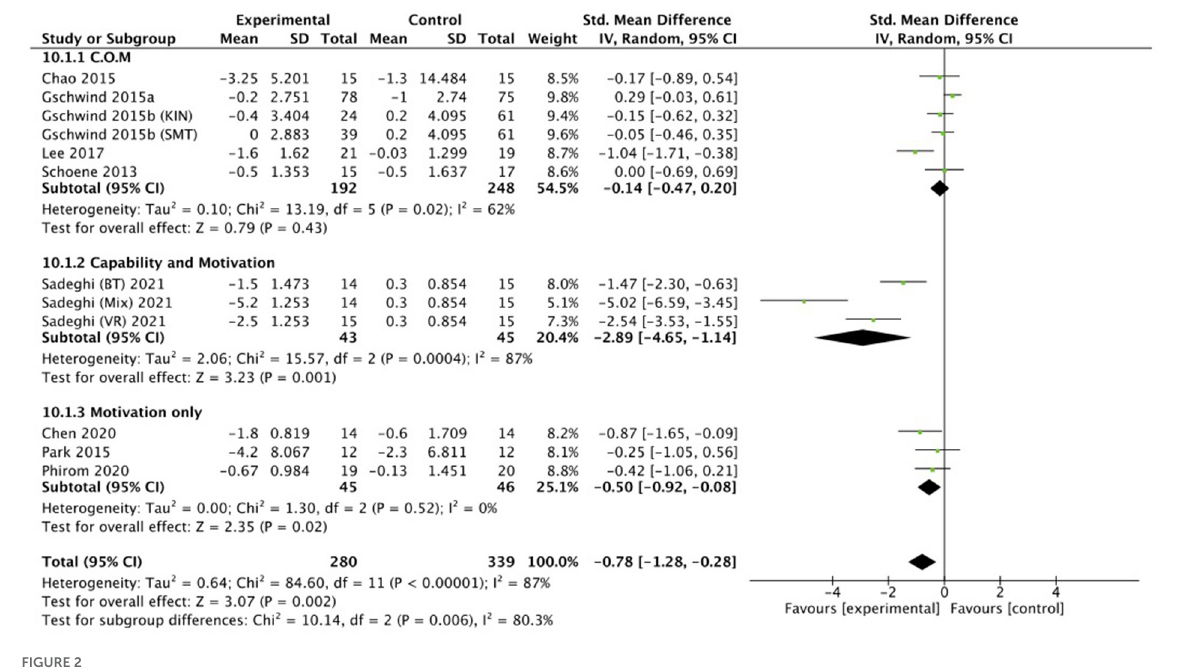
FIGURE2 Illustration of the forest plot for evaluating interventions involving capability, opportunity and motivation vs. capability and motivation vs. motivation only for effectiveness of intervention on measures of TUG balance